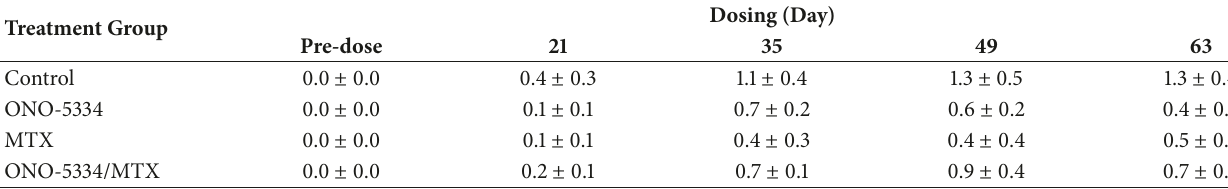
Table 1: General condition score in collagen-induced arthritis